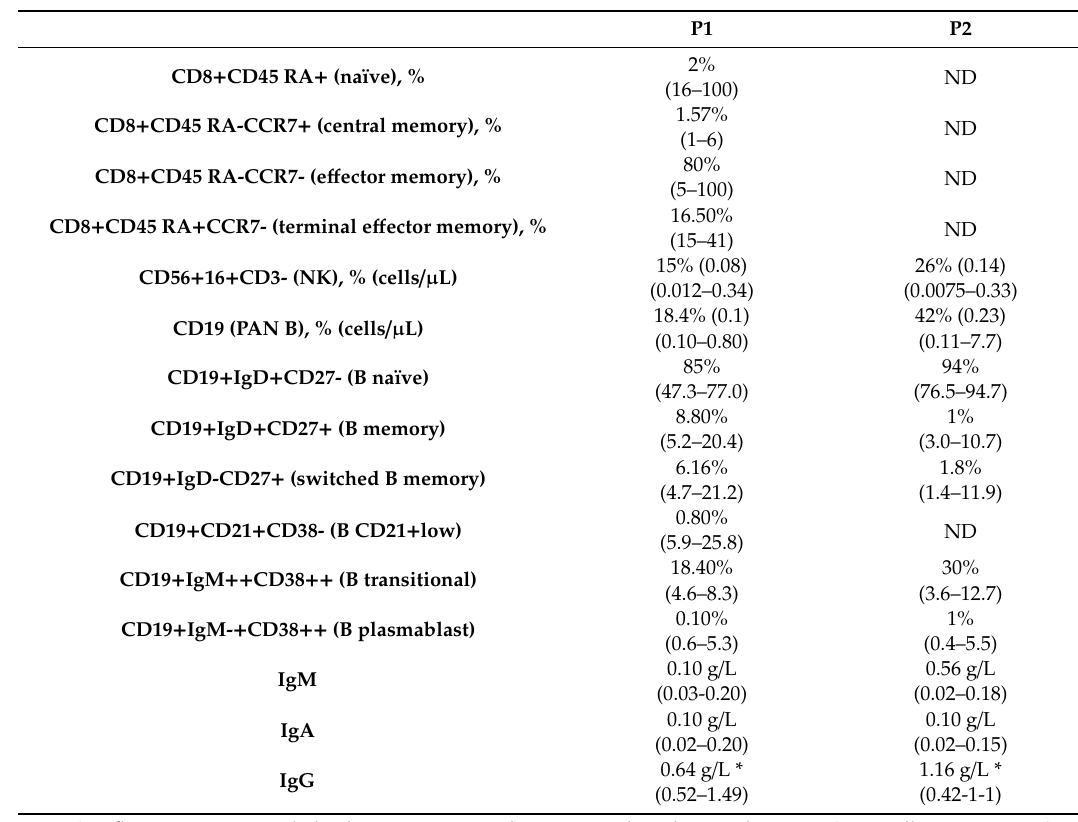
Figure 4. Stimulation with CpG. ( A ) The histograms represent B cell proliferation in a healthy control and P1. B cells were loaded with CFSE dye. The intensity of fluorescence decreased with cell division. The numbers indicate the percentage of B cells that had proliferated. ( B ) CD27 and IgM expression is determined in P1 and in a healthy donor with or without the addition of CpG (untreated, UNT). Different B cell populations can be recognized—CD27- mature/naive B cells, IgM+CD27+ memory B cells, IgM-CD27+ switched-memory B cells, and CD27bright plasmablasts (either IgM+ or IgM −, arrows ). Percentages of these subpopulations in the CD19+ B cells gate are indicated. Black arrows indicate plasmablasts. ( C ) IgM (white columns), IgA (grey columns), and IgG (black) concentration (µg/mL) in the supernatants after 7 days of stimulation with CpG in a healthy control and in P1. The immunoglobulin levels in both patients’ sera showed a reduction of IgG with normal levels of IgA and IgM. IL-7R α (CD127) expression on P1 T lymphocytes was severely reduced on total CD3+ and CD4+ cells and almost absent on CD8+ T cells, while the mother’s CD4+ and CD8+ T lymphocytes showed only a slightly decreased CD127 expression (Figure 5).